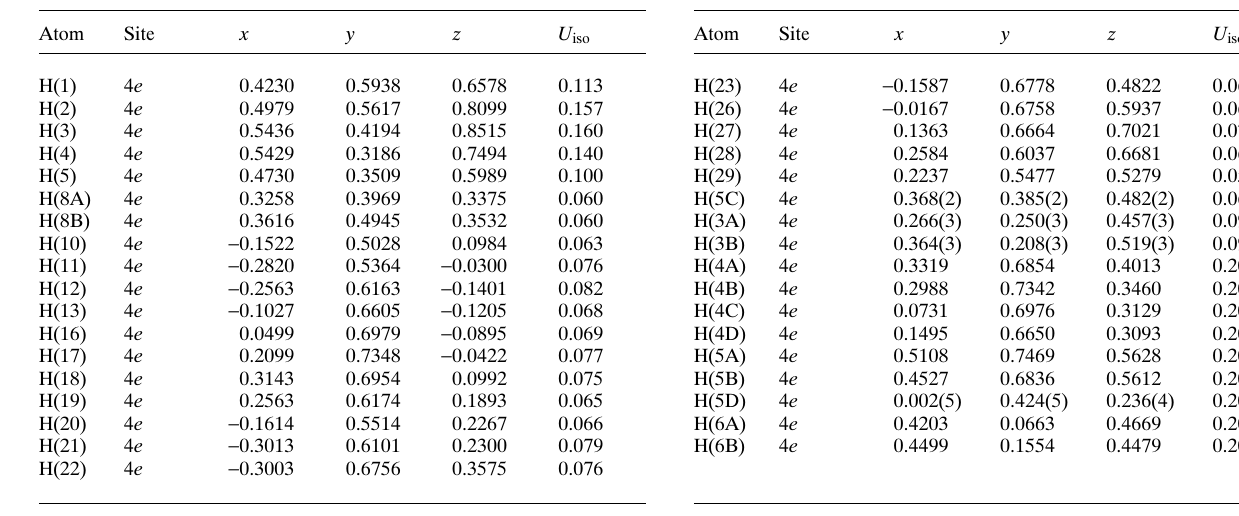
Table 2. Atomic coordinates and displacement parameters (in Å 2 )